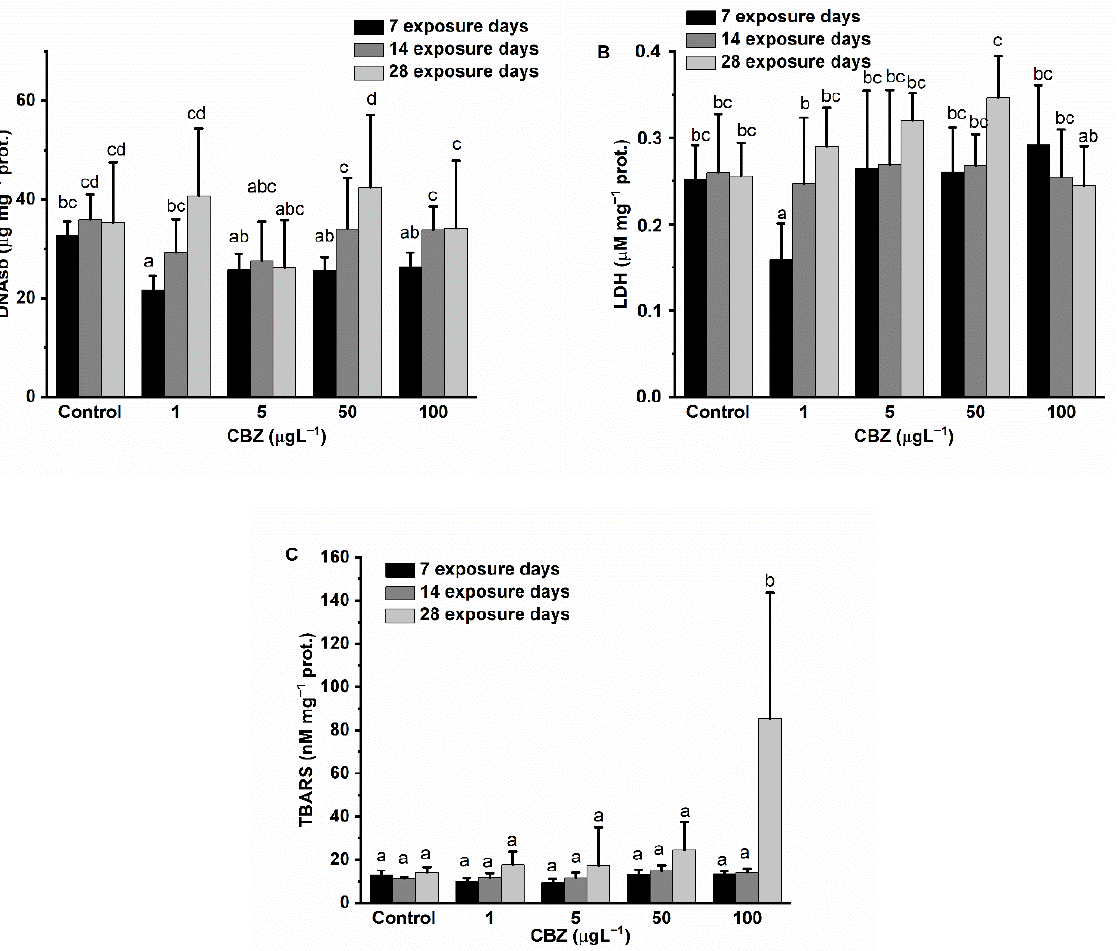
Figure 7. Changes in the DNA strand breaks ( A ), LDH activity ( B ), and level of lipid peroxidation ( C ) in the liver of Cyprinus carpio exposed to CBZ for 7, 14, and 28 d. Data are expressed as mean ± standard deviation of three replicates ( n = 3). Same letters designate no significant differences at p < 0.05 after a two ‐ way ANOVA followed by Tukey’s post ‐ hoc